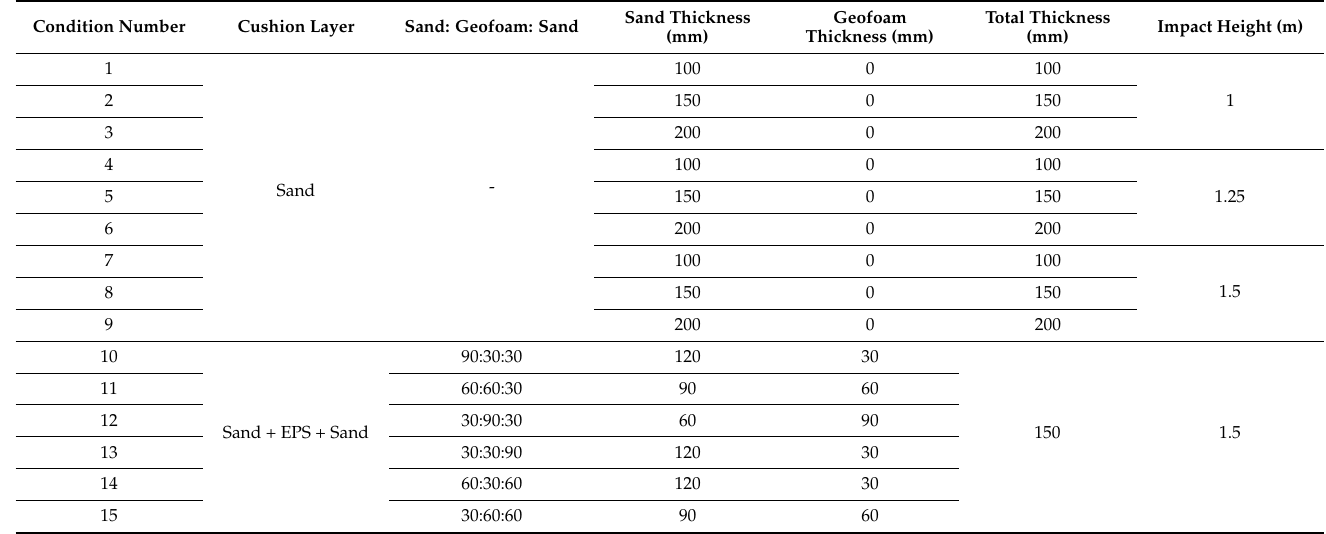
Table 1. Statistical table of multi-impact test conditions for sand cushion and sand–EPS cushion.